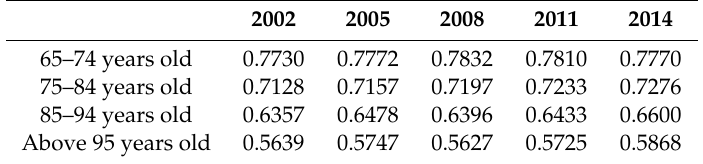
Table 4. QWB scores distribution of the elderly in di ff erent age groups from 2002 to